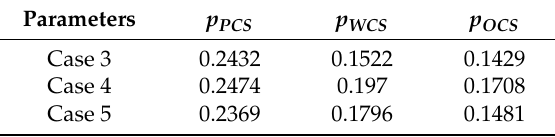
Table 7. The parking probability obtained in PSO.